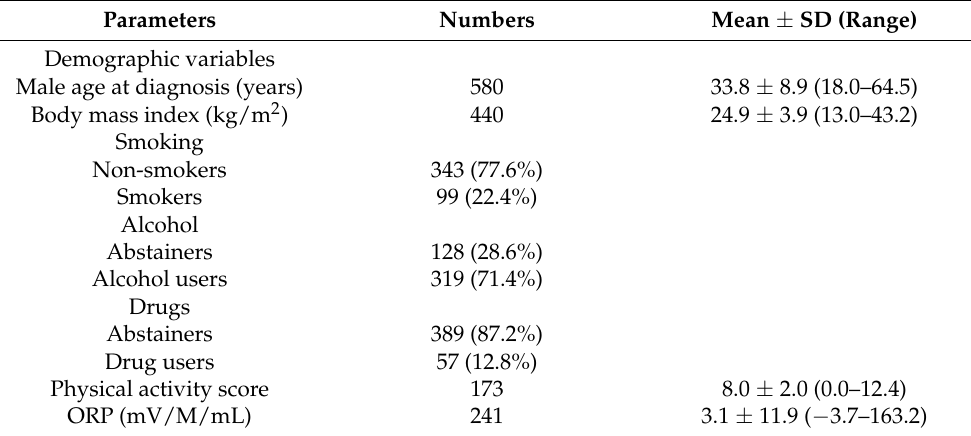
Table 1. Descriptive statistics of all participants.